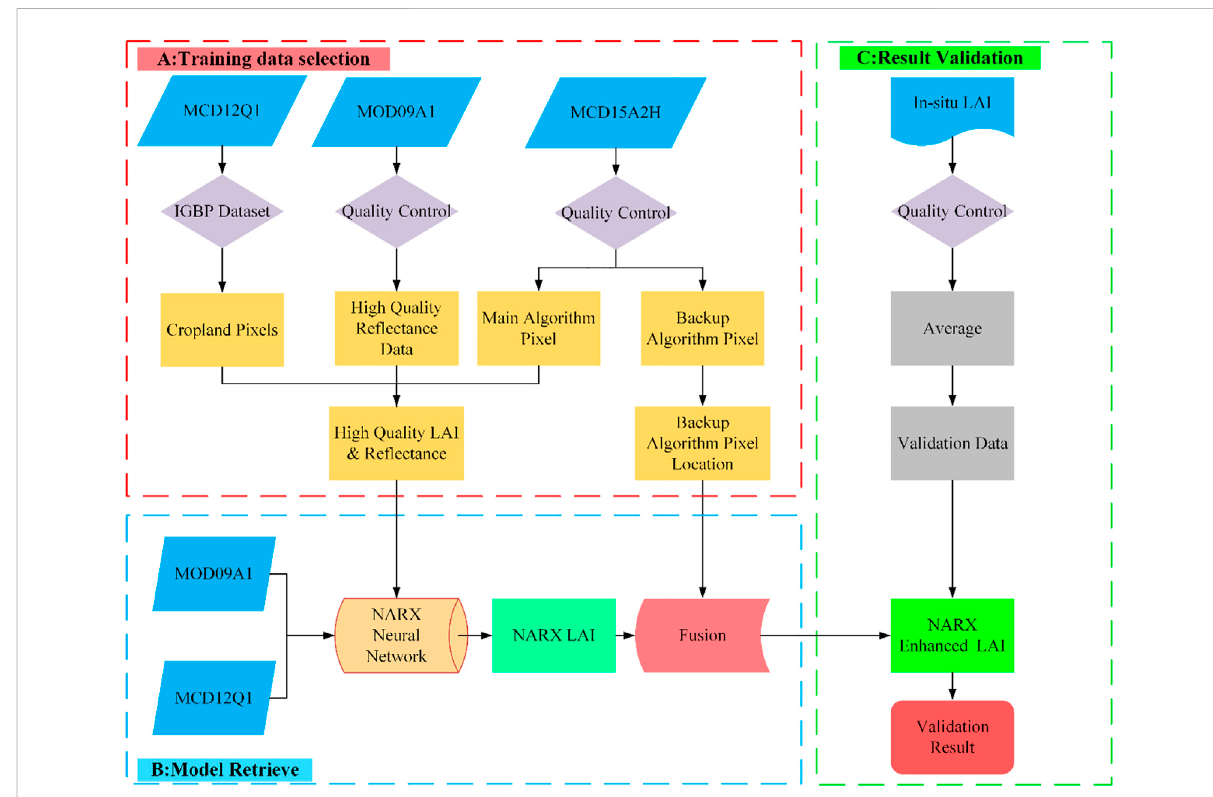
FIGURE 2 Flow chart of the NARXNN method to generate the NARX-enhanced LAI product using the MODIS datasets.